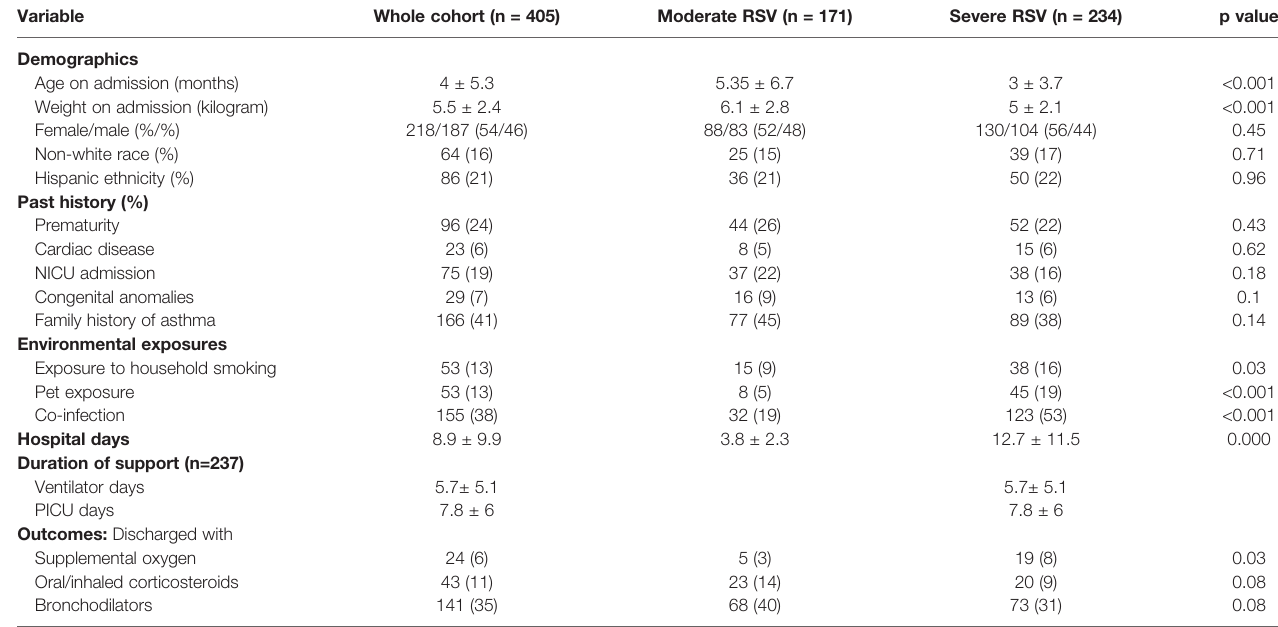
TABLE 1 | Demographics of the cohort strati fi ed by moderate and severe RSV disease.